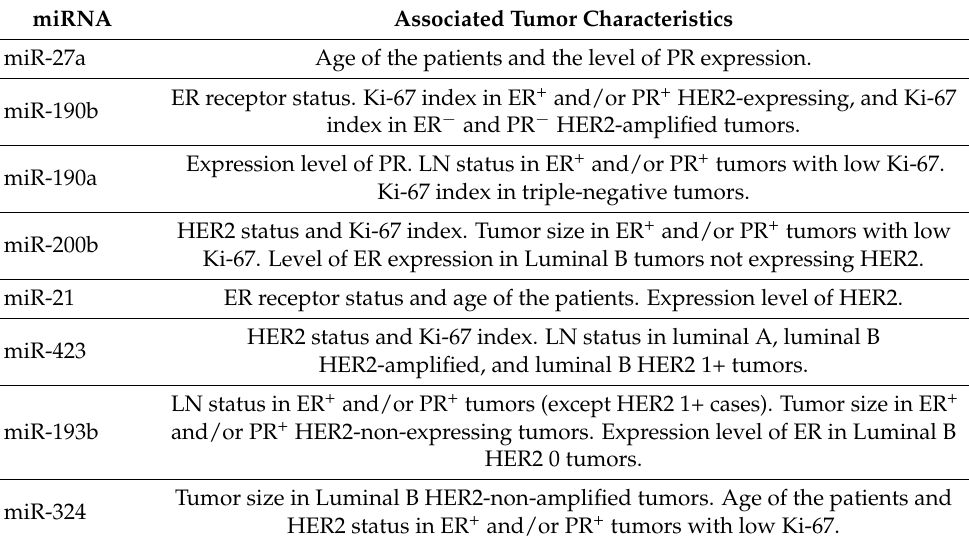
Table 8. The identified relation between miRNAs levels and tumor characteristics. miRNA Associated Tumor Characteristics miR-27a Age of the patients and the level of PR expression. ER receptor status. Ki-67 index in ER + and/or PR + HER2-expressing, and Ki-67 miR-190b index in ER − and PR − HER2-amplified tumors. Expression level of PR. LN status in ER + and/or PR + tumors with low Ki-67. miR-190a Ki-67 index in triple-negative tumors. HER2 status and Ki-67 index. Tumor size in ER + and/or PR + tumors with low miR-200b Ki-67. Level of ER expression in Luminal B tumors not expressing HER2. miR-21 ER receptor status and age of the patients. Expression level of HER2. HER2 status and Ki-67 index. LN status in luminal A, luminal B miR-423 HER2-amplified, and luminal B HER2 1+ tumors. LN status in ER + and/or PR + tumors (except HER2 1+ cases). Tumor size in ER + miR-193b and/or PR + HER2-non-expressing tumors. Expression level of ER in Luminal B HER2 0 tumors. Tumor size in Luminal B HER2-non-amplified tumors. Age of the patients and miR-324 HER2 status in ER + and/or PR + tumors with low